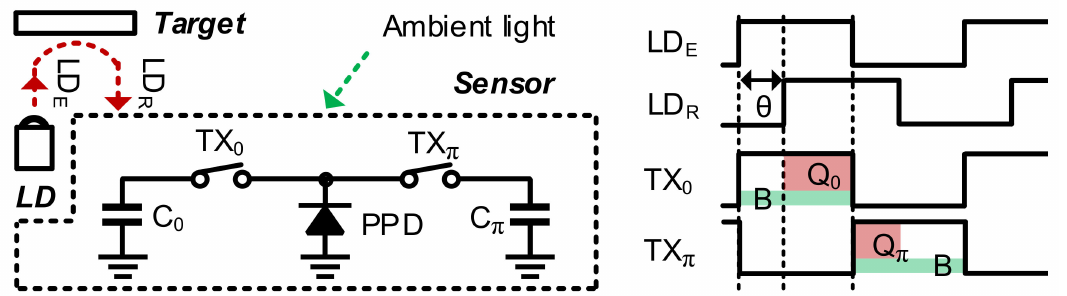
Figure 1. Operation principles of an indirect time-of-flight (iTOF) depth